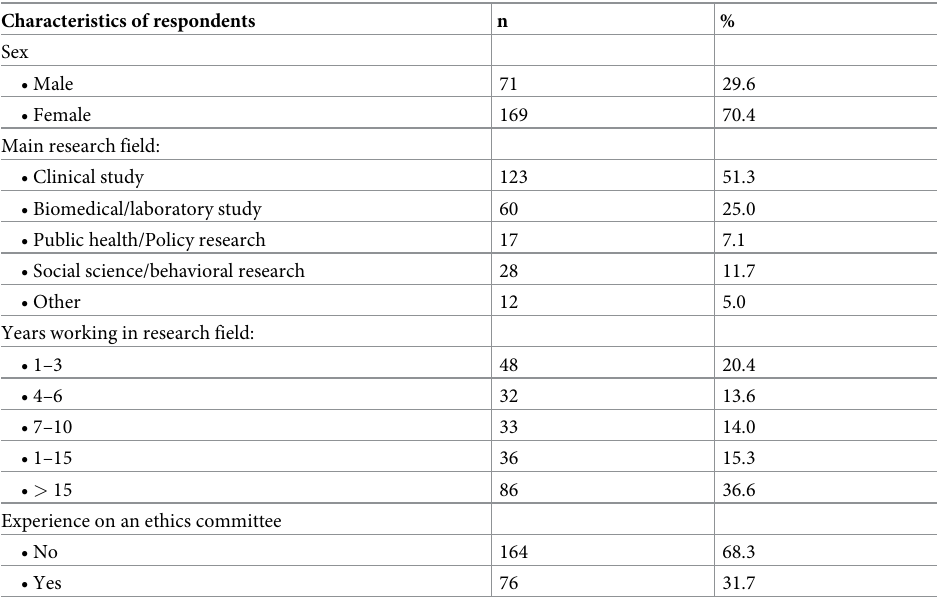
Table 1. Characteristics of study respondents (N =